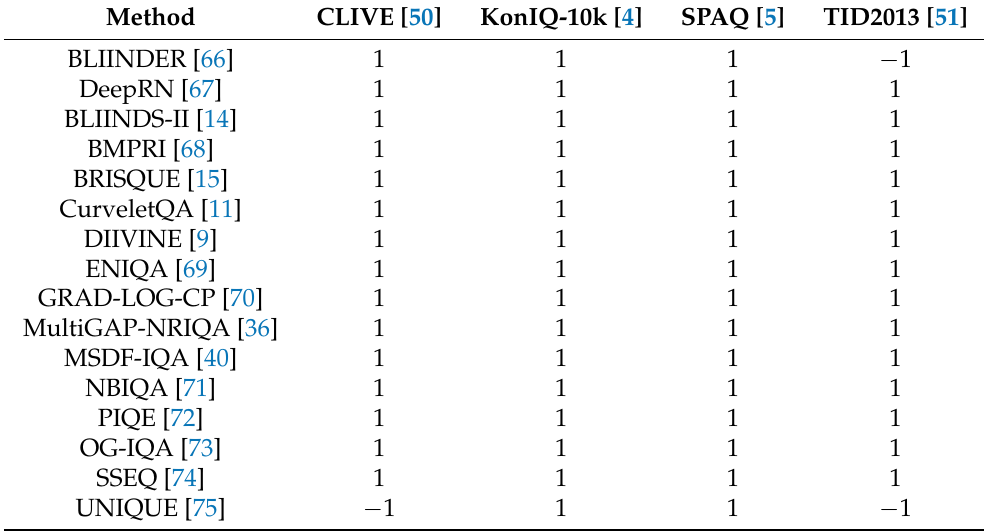
1) means that the proposed DF-CNN-IQA Table 7. Results of the one-sided t -tests. Symbol 1 ( − method is statistically significantly ( 95% confidence interval, p = 0.05 significance level ) better (worse) than the NR-IQA method in the row on the IQA benchmark database in the